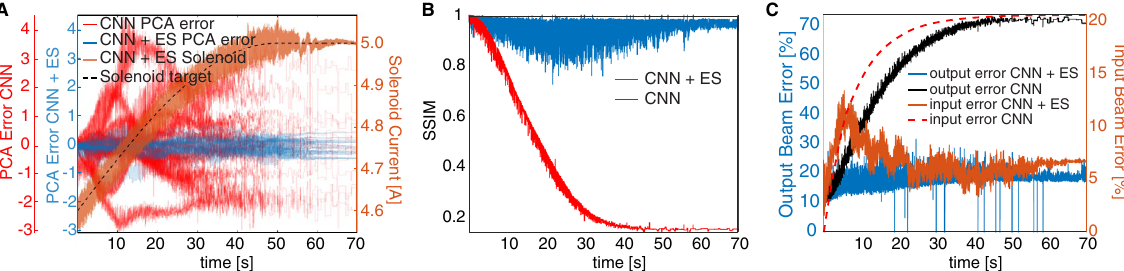
Figure 7. ( A ) PCA component tracking error shown with CNN alone and with CNN + ES, in the latter case the solenoid strength is also tracked. ( B ) CNN + ES tracks the output beam. ( C ) Output and input beam distribution errors continuously minimized.